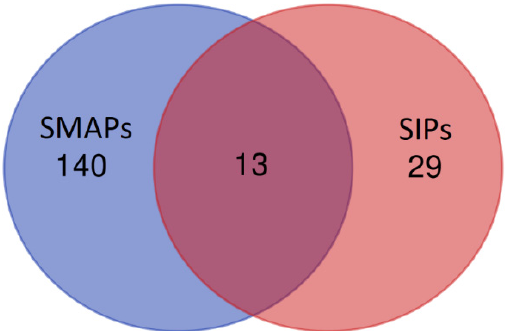
Figure 5. Venn diagram showing the number of proteins identified in the sperm intracellular proteins (SIPs) and the sperm membrane-associated proteins (SMAPs) of the dog ( Canis lupus familiaris ) cauda epididymal spermatozoa.